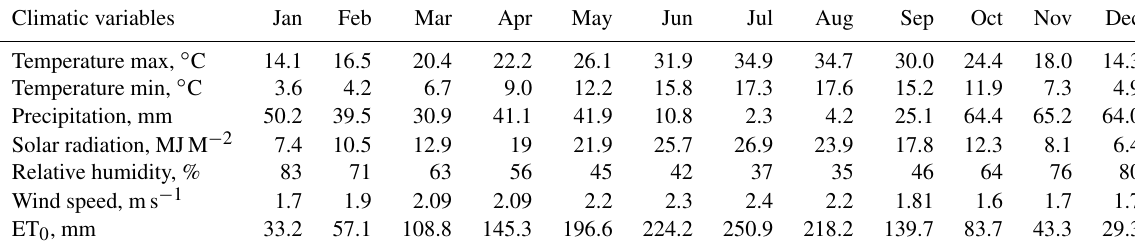
Table A1. The average monthly climatic data of Badajoz in Spain. Climatic variables